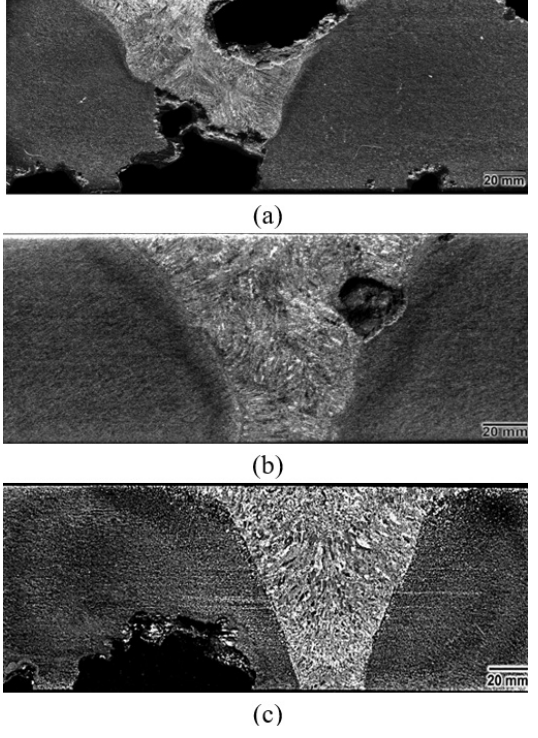
Figure 13. Macrographs of specimens after the ferric chloride test for 72 h at 50 ºC for the three different welding energies. (a) 0.5 kJ.mm -1 ; (b) 1.0 kJ.mm -1 ; (c) 3.5 kJ.mm -1 . OM, electrolytic oxalic acid solution etching. The 0.5 kJ.mm -1 welding showed a greater proportion of corroded region, with more significant corrosion in the MZ region. The 1.0 kJ.mm -1 welding showed lesser corrosion in the BZ. The 3.5 kJ.mm -1 welding did not present corrosion in the MZ and BZ regions, but it presented accentuated corrosion in the HAZ. OM, electrolytic etching in oxalic acid